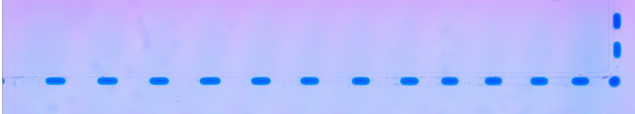
Figure 4. Under optimal operating conditions (P + ve = 40 kPa, P − ve = − 22 kPa, 1 Hz), droplets can be formed with a length of 0.40 mm ± 0.02 mm (measured from video footage as each droplet leaves the intersection area). A train of droplets is generated at the T intersection at the far left and moves into the zig-zag section as it leaves the figure (the droplets had been generated for 1 min prior to taking these images). The length from the intersection to the first corner (i.e., from left to right) is 12.5 mm, and due to a limited field of view, this image was formed from several individual pictures. There is a slightly smaller appearance of the droplets on the right, and this appears to be due to variations in the channel size.